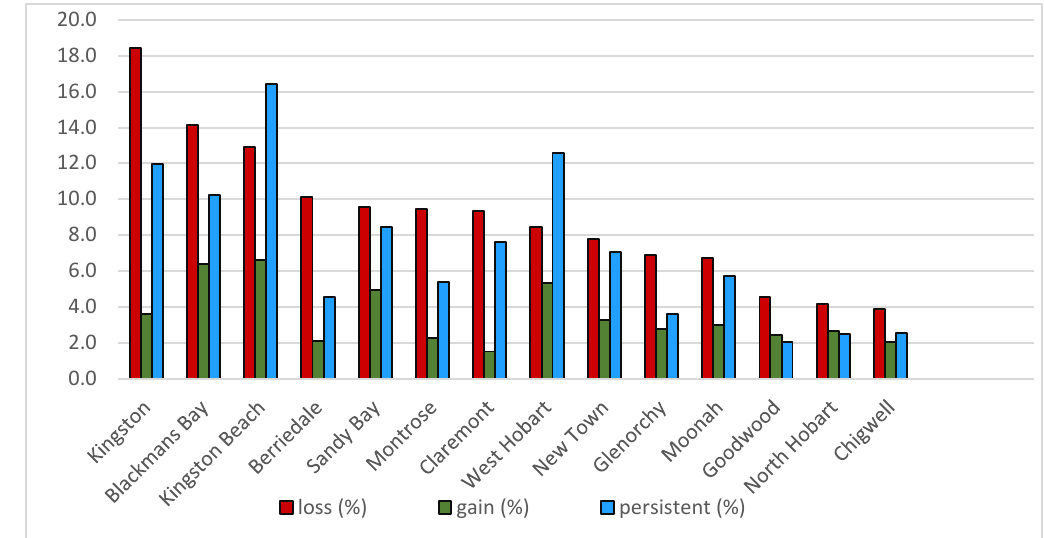
Figure 11. Percentages of tree cover area losses, gains and persistence within fourteen sample patches with four hectares of area each.